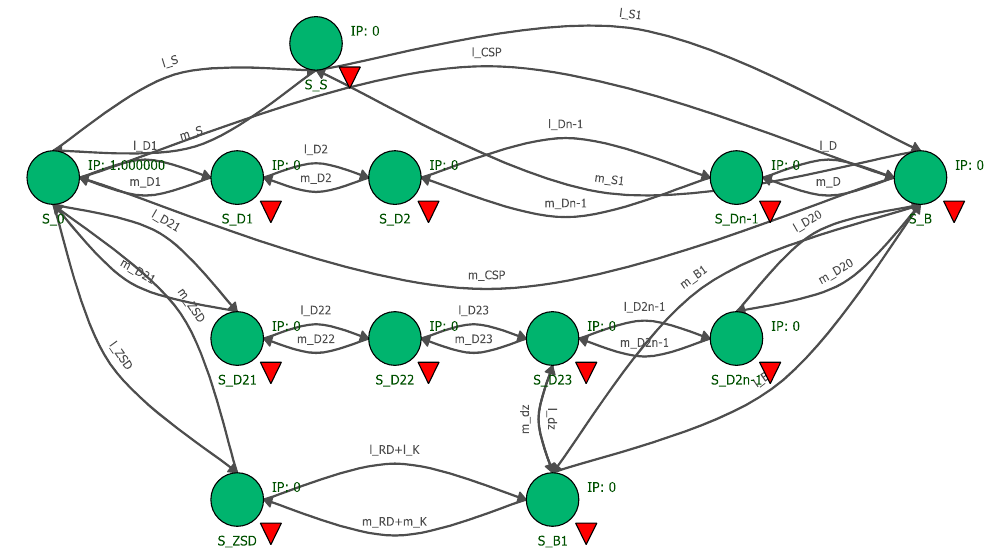
Figure 8. Migration of possible states of an FAS with a smoke exhaust system based on common fire detection (Figure 6) [printout from the BlockSim software].